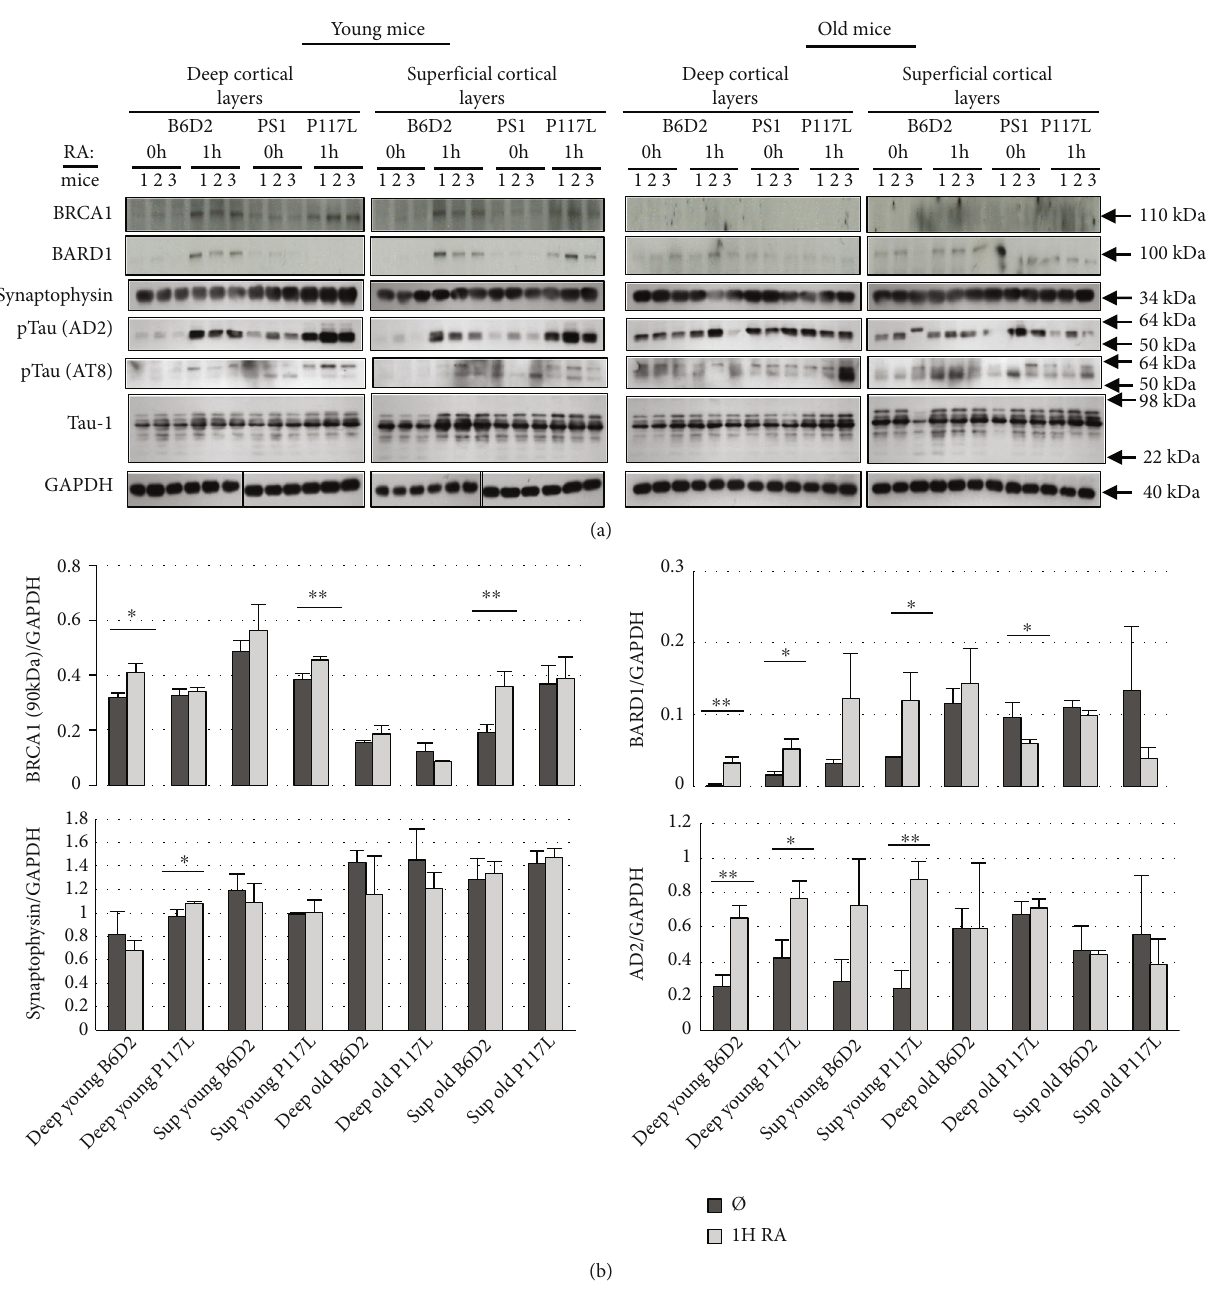
Figure 7: Detection by Western blot (a) of BRCA1 (90 kDa isoform) and full-length (FL) BARD1, synaptophysin, phosphorylated Tau (pTau), and unphosphorylated Tau (Tau-1) in the deep and the super fi cial (Sup) cortical layers of B6D2 and PS1 P117L young and old male mice, treated or not with all-trans retinoic acid (RA). The full-length BRCA1 protein was below detection level. Three mice (1, 2, and 3) were used each time. The B6D2 and PS1 P117L mice were 1.5- and 17-months-old. Synaptophysin was used as a synaptic marker, pTau (AD2 and AT8) and Tau-1 as cytoskeletal markers, and GAPDH as a loading control. In (b), the protein expressions of BRCA1, BARD1, synaptophysin, and pTau (AD2), visualized in (a), were measured (normalization with GAPDH). Statistically signi fi cant di ff erences due to the RA treatment are indicated, ∗ p < 0 : 05 , ∗∗ p < 0 : 01 , n = 3